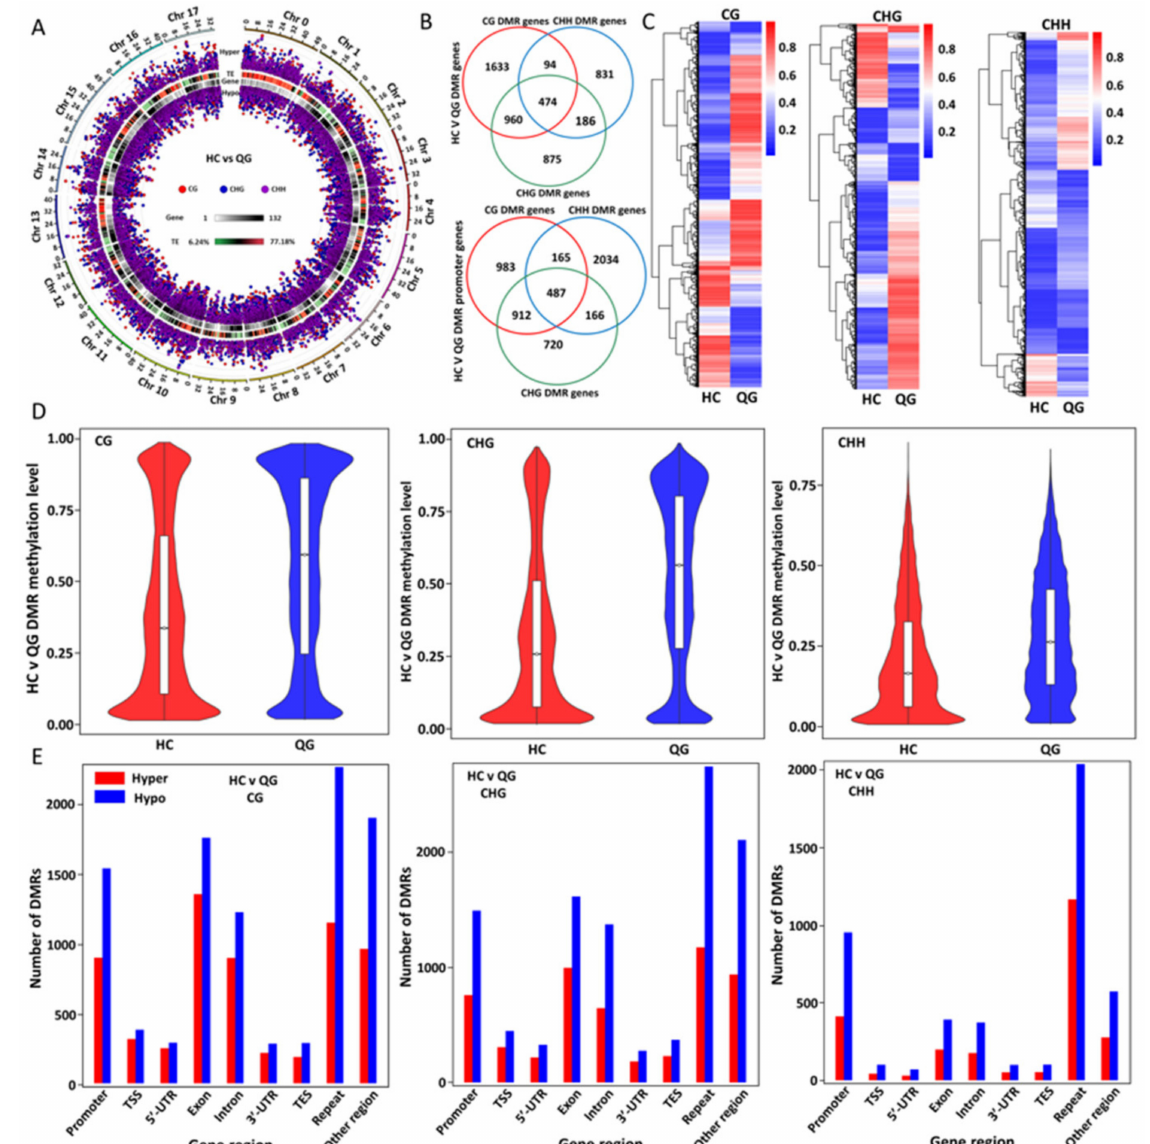
Figure 3. DMRs between ‘HC’ and ‘QG’ mature fruts. ( A ) Circos plot presenting the hyper- and hypo-DMRs in the CG, CHH, and CHG contexts between ‘HC’ and ‘QG’ mature fruits. ( B ) Venn diagrams of the DMRsin genes and DMRsin promoters between ‘HC’ and ‘QG’ mature fruits. DMRs in the center would contain all three methylation types (CG, CHH, and CHG). ( C ) Heat maps clustering the DMRs in the CG, CHH, and CHG contexts between ‘HC’ and ‘QG’ mature fruits. ( D ) Violin plots comparing the DMRs in the CG, CHH, and CHG contexts between ‘HC’ and ‘QG’ mature fruits. ( E ) Number of DMRs in the CG, CHH, and CHG contexts in various genomic regions in ‘HC’ and ‘QG’ mature